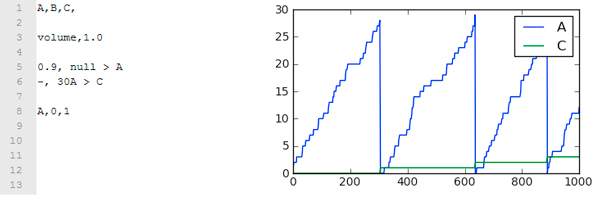
QDC's syntax example. Here it is an example of an immediate reactions; the A molecule is continuously added by the uptake reaction 0.9 null > A; the immediate reaction is identified by the hyphen sign ("-") that is present instead of a kinetic coefficient, and acts by producing one C molecule every 30 A molecules; notice the resulting oscillatory behavior of the A specie.